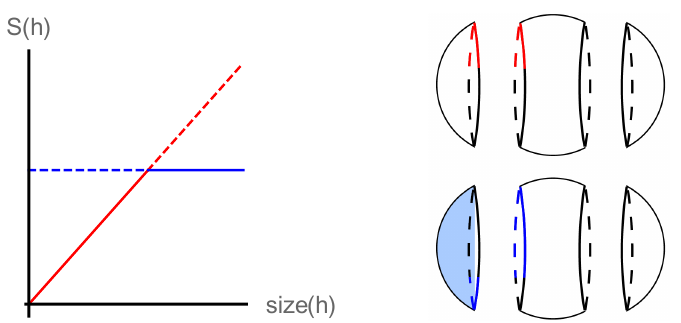
Figure 7 . Left: there are two extremal surfaces for the entropy of a subregion h of one horizon, marked as red and blue above. The minimal one exhibits a transition: the entropy of a subregion grows as twice its size (solid red curve) until the halfway point, where it saturates at the horizon area (solid blue curve) and the entanglement wedge becomes the interior of the horizon. This transition will be smoothened out by anchoring at the stretched horizon. Right: the red saddle and blue saddle drawn for configurations where they are minimal, with the entanglement wedge shaded. (These extremal surfaces do not live at fixed global time — they are drawn that way above for simplicity, see appendix C for a discussion.) This is reminiscent of the island transition in an eternal black